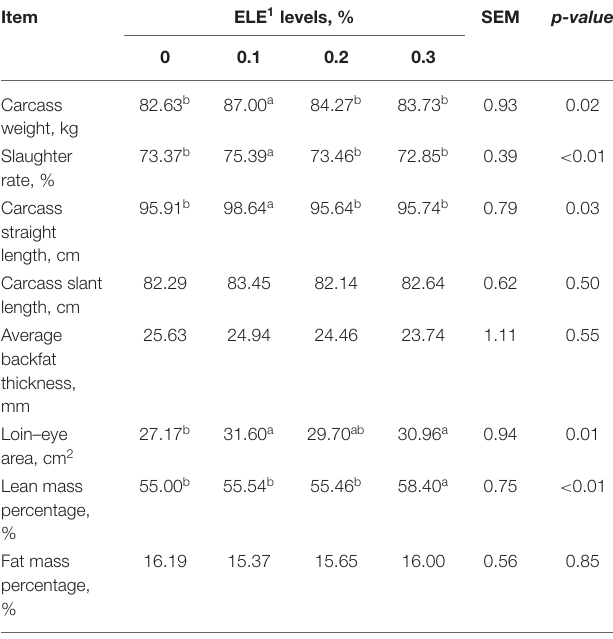
TABLE 6 | Effects of dietary ELE on serum cytokine levels of growing–finishing pigs.